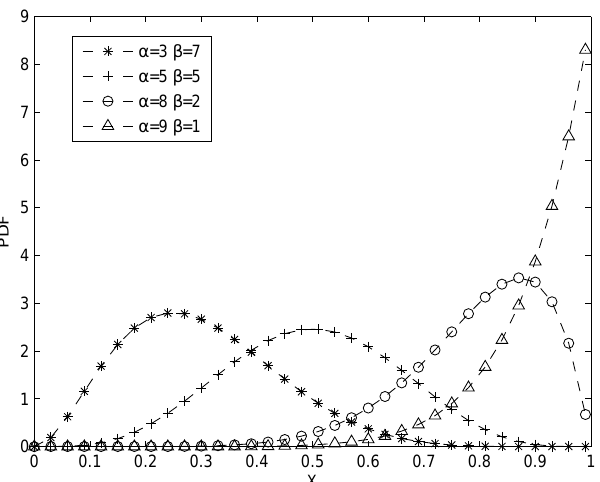
Figure 3. PDF of beta distribution with parameter α and β